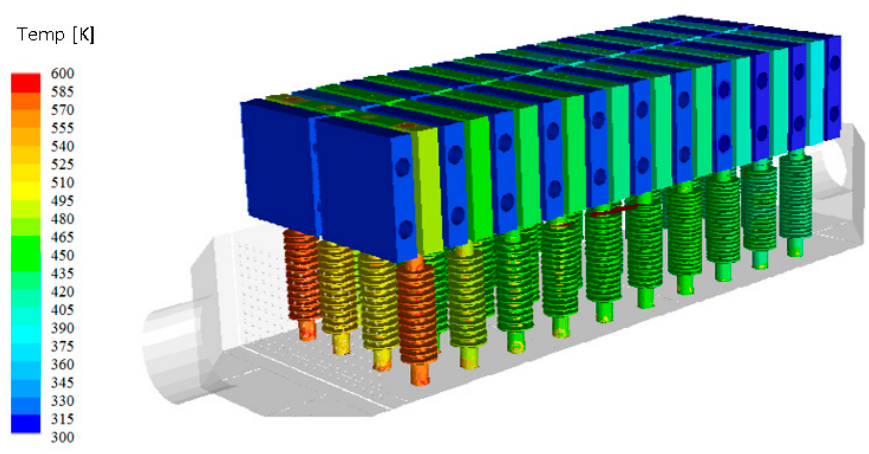
Figure 6. Temperature distribution on heat pipe surfaces and aluminum blocks, high-engine-load case.